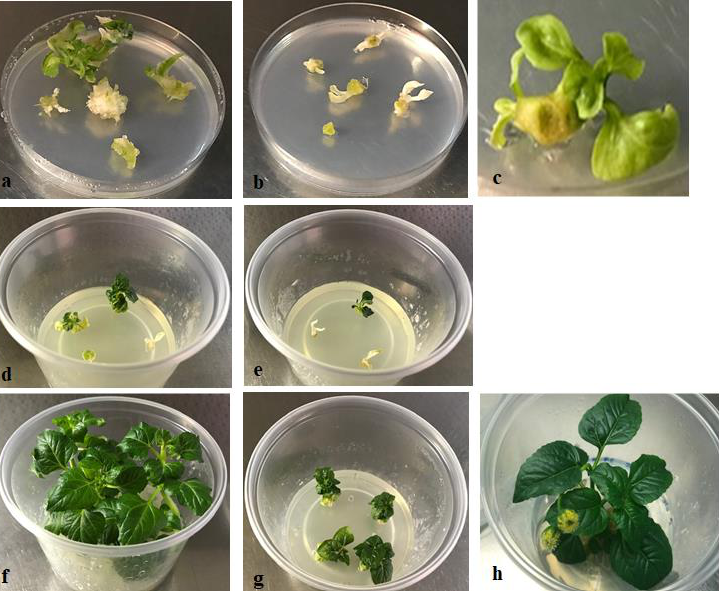
Figure 3. Plant transformation in Acmella oleracea . ( a,b ) Nodal explants infected with Agrobacterium LBA4404::pBI121 showing regenerated shoots after 30 days of culture on LS1 medium with the addition of 10 mg/L kanamycin and 500 mg/L cefotaxime. ( c ) Control (not infected) nodal explants on the same selection medium 30 days after co-cultivation with Agrobacterium . ( d , e ) Isolated putative transgenic shoots 40 days after co-cultivation with Agrobacterium on LS1 selection medium. ( f ) Acmella plantlets isolated from control nodal explants after two months of growth on LS medium devoid of hormones; Acmella transgenic shoots after two ( g ) and four months ( h ) of growth on LS selection medium containing 10 mg/L kanamycin.